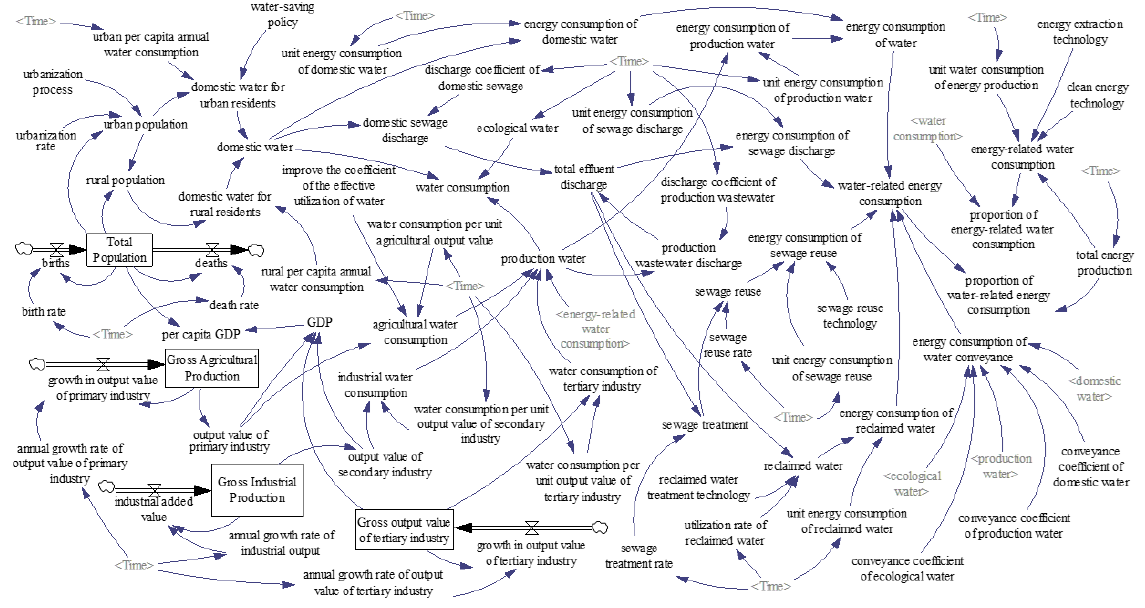
Figure 4. SD model for the water–energy coupling system.